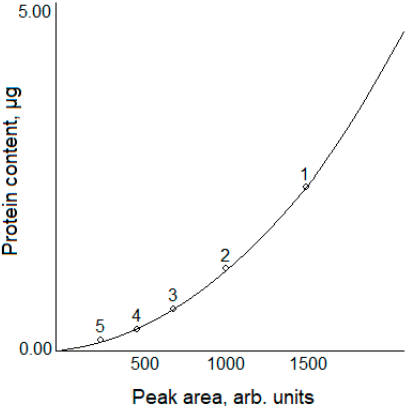
Figure 4. The calibration plot for BSA quantification.